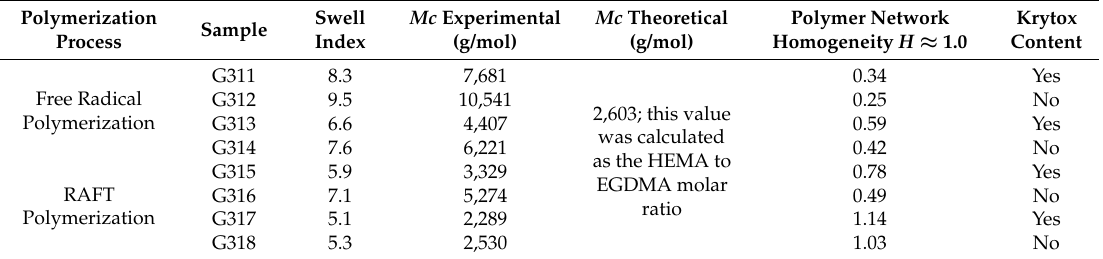
Table 3. Estimation of average molecular weight between crosslinks from the Flory–Rehner